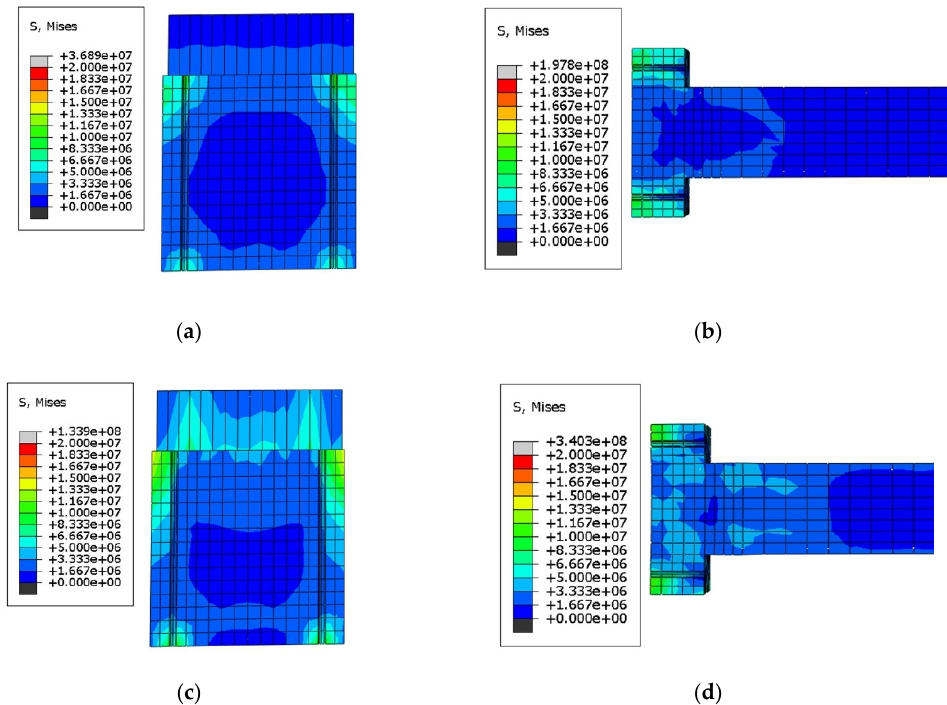
Figure 28. Stress cloud of the specimen J2 bolt-hole section: ( a ) − 20 mm stage column core section; ( b ) − 20 mm stage beam expanded end section; ( c ) − 90 mm stage column core section; ( d ) − 90 mm stage beam expanded end section.